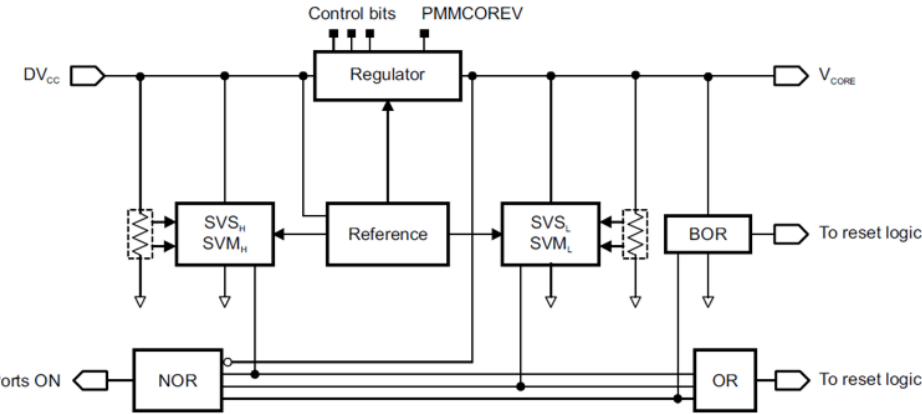
Figure 4. Power management module block diagram following [56].